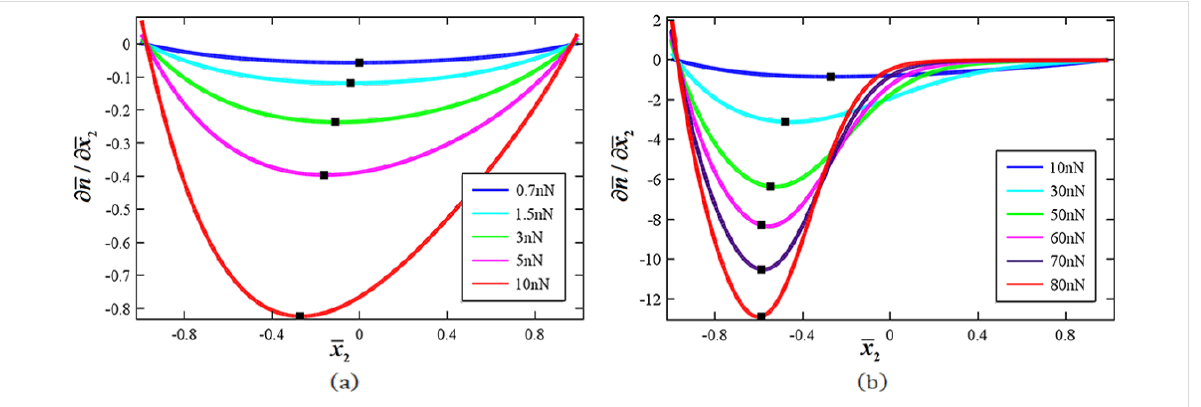
Figure 2: Nonlinearity as a result of carrier drift for n 0 = 1.0·10 23 m − 3 as a function of the end force P . a) P = 0.7, 1.5, 3.0, 5.0 and 10.0 nN; b) P = 10, 30, 50, 60, 70 and 80